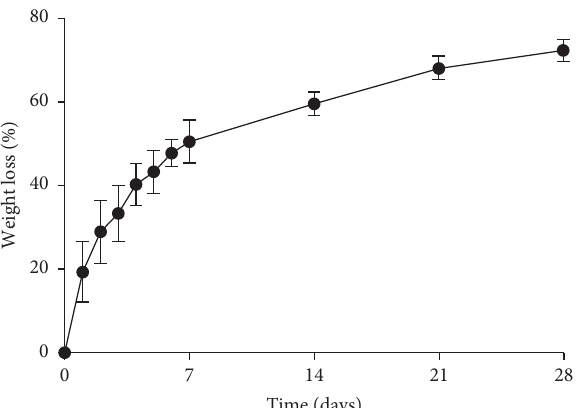
Figure 7: Percentage weight loss of the DFS scafold during in vitro degradation at 37 ° C in PBS solution maintained at pH 7.4. Te degradation rate was measured as weight lost by the scafold per